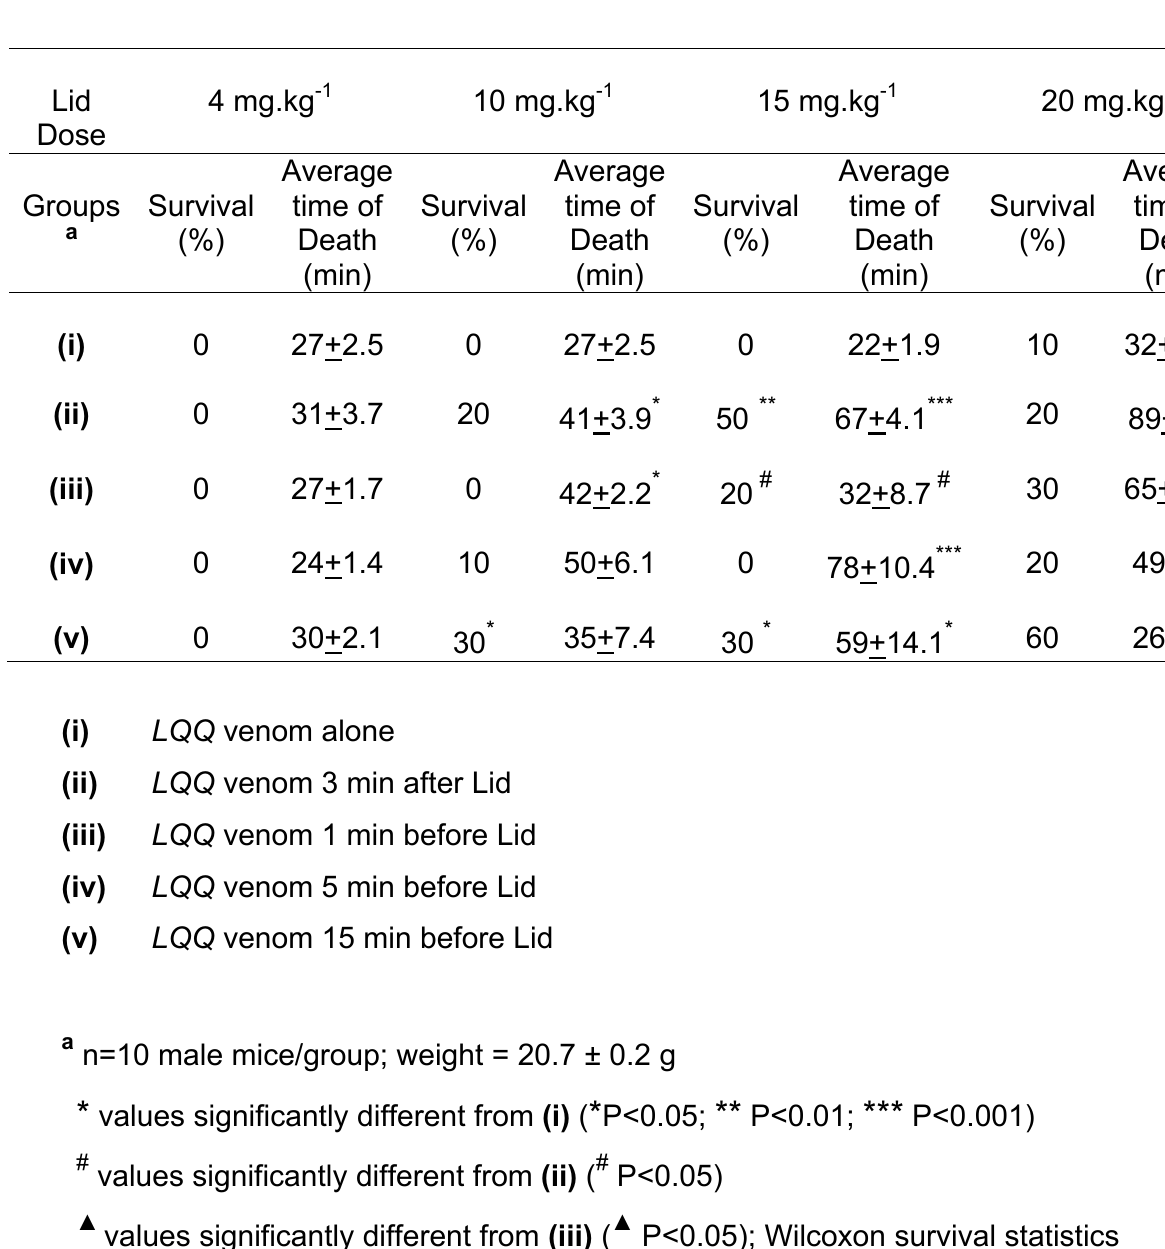
Table 4: Percent survival and average time of death of mice intravenously injected with lidocaine (Lid) at different times before and after LQQ venom (300 (cid:80) g.kg -1 ,